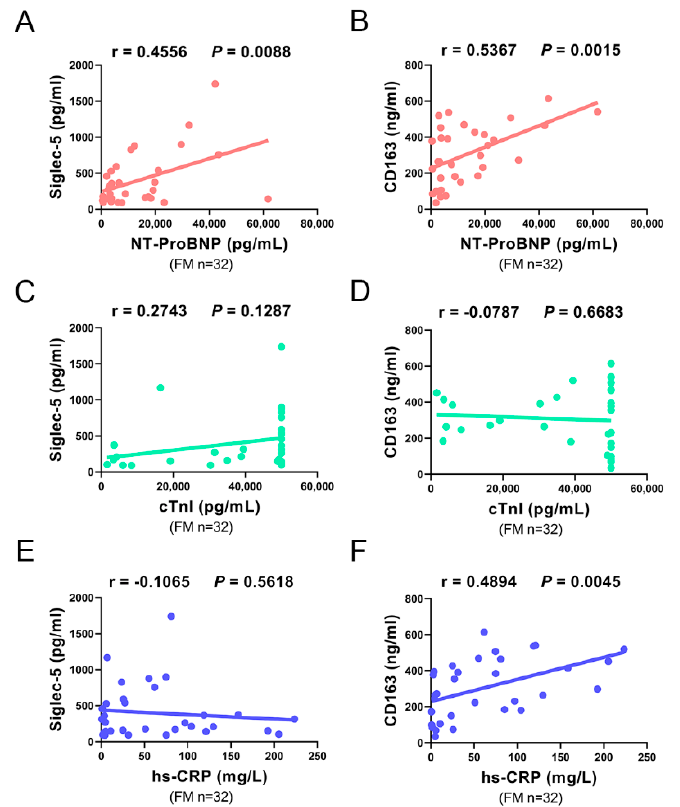
Figure 3. Correlation between plasma Siglec-5 and CD163 concentrations with fulminant myocarditis- related clinical parameters. Correlation analysis of plasma Siglce-5 and CD163 concentrations with N-terminal pro-B-type natriuretic peptide (NT-ProBNP) ( A , B ), cardiac troponin I (cTnI) ( C , D ), and high- sensitivity C- reactive protein (hs-CRP) ( E , F ) in 32 patients with FM. r indicates the correlation